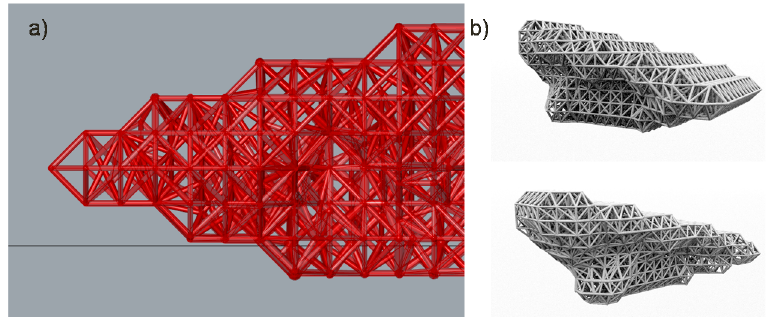
Figure 41. ( a ) Detail of the variable density lattice structure. ( b ) Visualization of the 3D model of solution number 4.